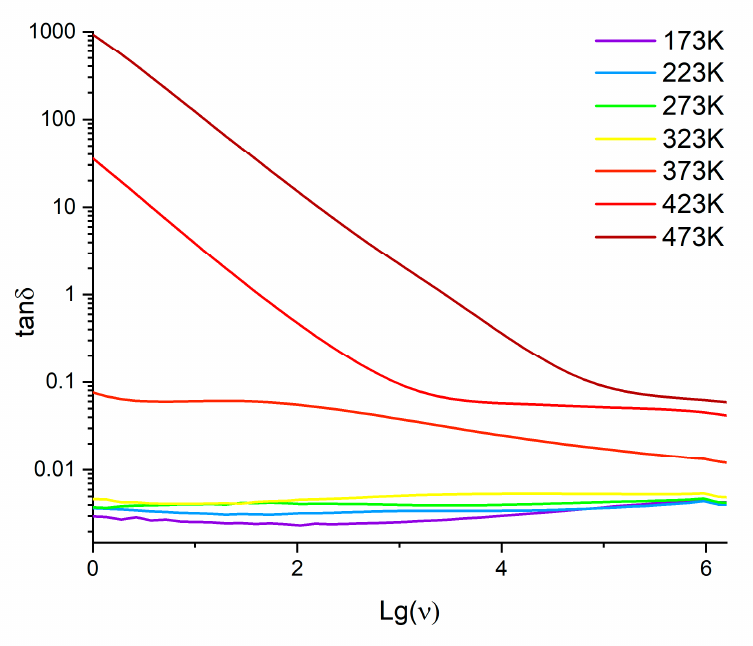
Figure 8. The frequency dependences of tan δ for polyNBi at various temperatures.